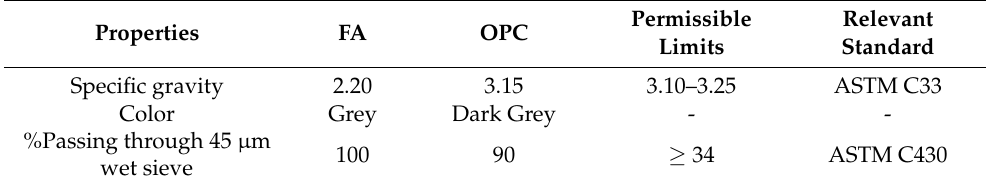
Table 2. Physical traits of FA and OPC.